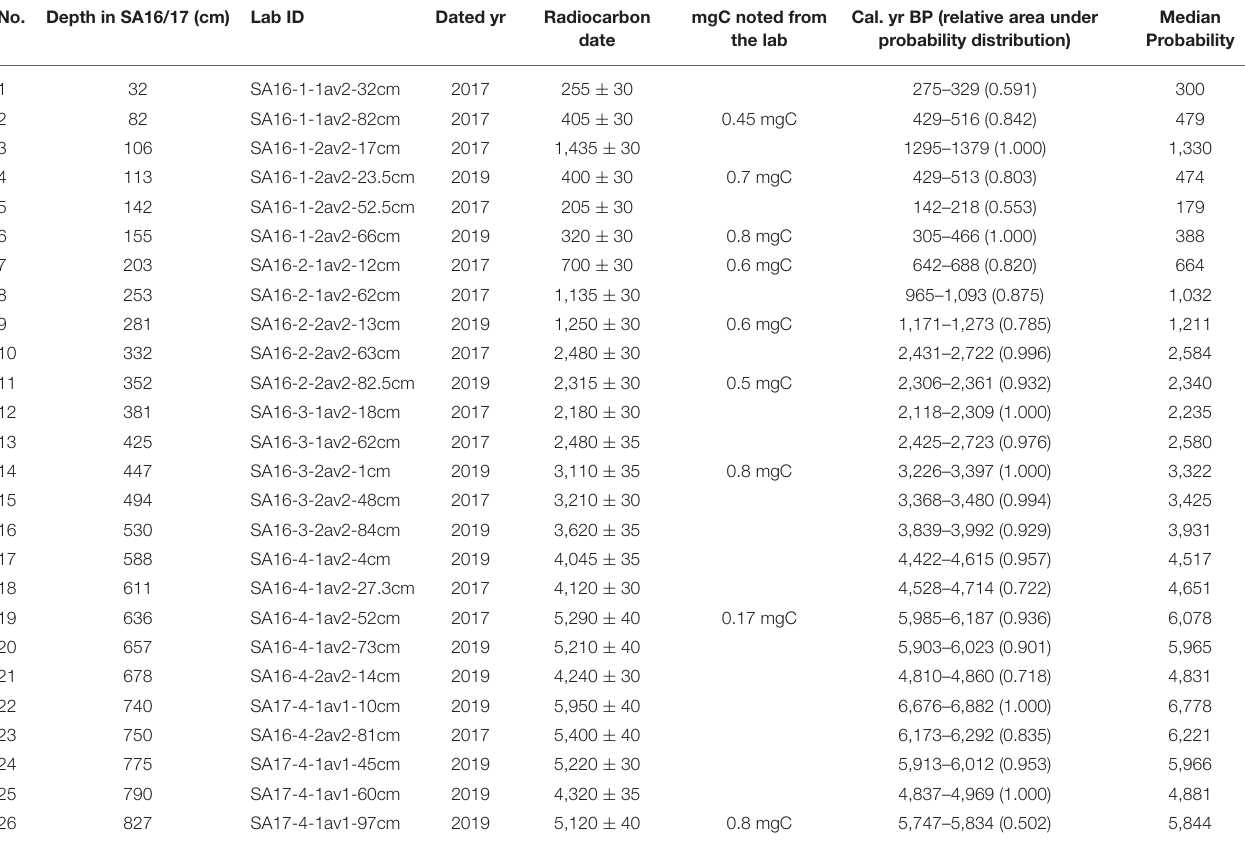
TABLE 1 | Summary of the 26 radiocarbon samples (terrestrial plant remains) analyzed at the Poznan Radiocarbon Laboratory. No. Depth in SA16/17 (cm) Lab